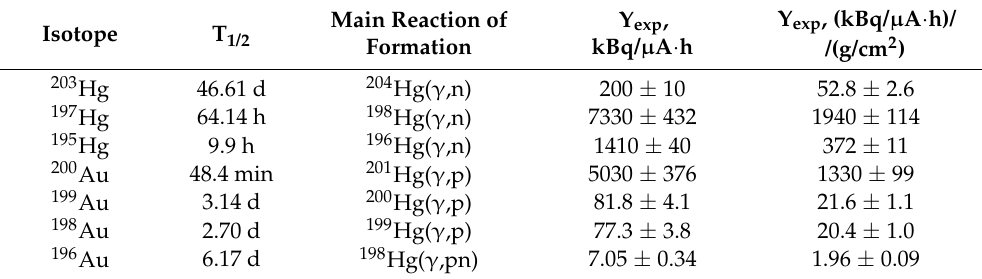
Table 1. Radionuclide composition of irradiated Hg and experimental yields of reactions. Main Reaction of Isotope T 1/2 Formation